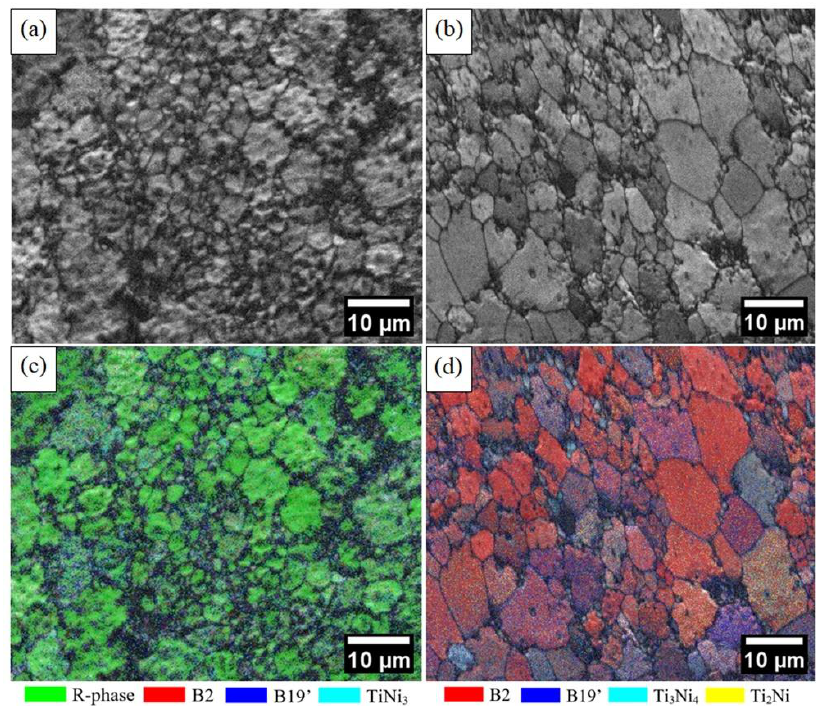
Figure 6. The image quality (IQ) map: ( a ) MW and ( b ) CS sample. EBSD phase maps + IQ map: ( c ) MW sample with the R- phase in green, B2 in red, B19′ in blue , and TiNi 3 in cyan; ( d ) CS sample with B2 in red, B1 9′ in blue, Ti 3 Ni 4 in cyan, and Ti 2 Ni in yellow.